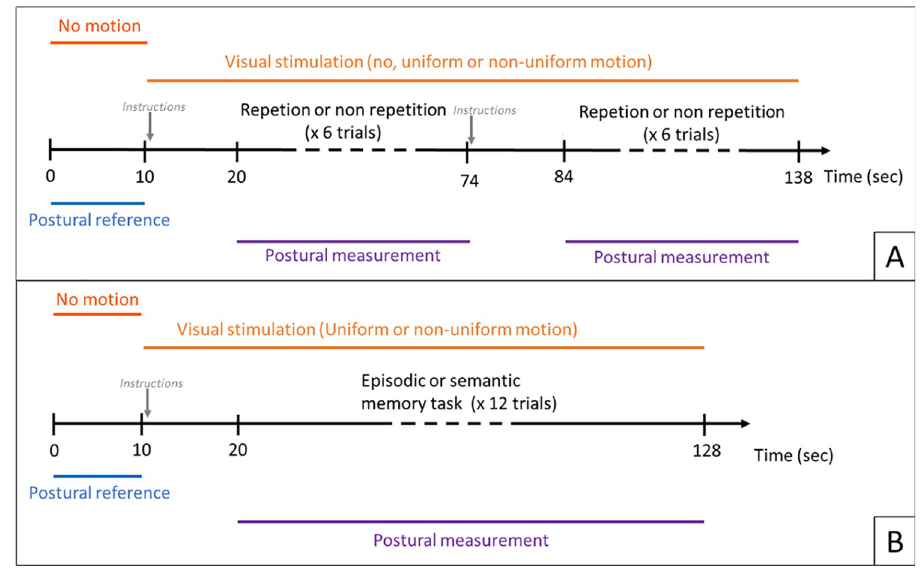
Fig 1. Block procedure. Time sequence of tasks during one block for the preliminary experiment (A) and for the main experiment (B).